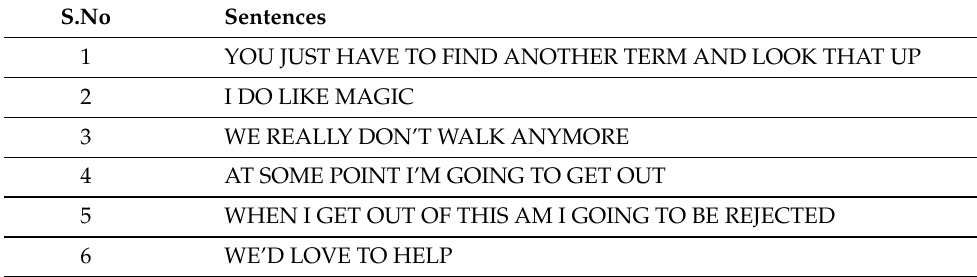
Table 4. The proposed method accurately recognized these